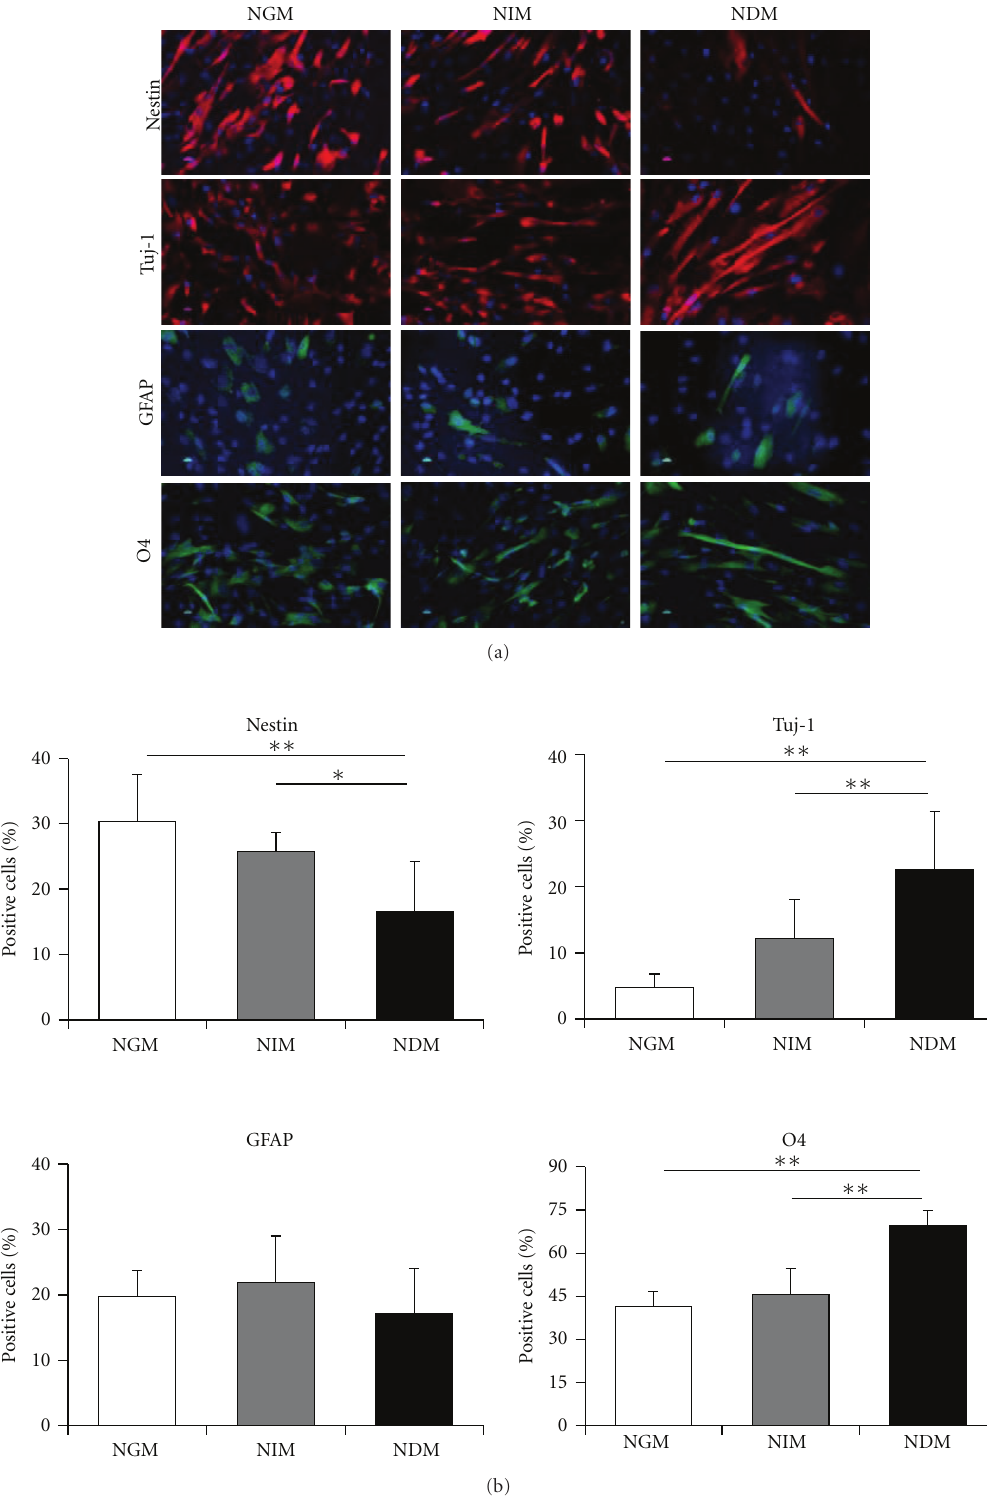
Figure 2: Neural marker expression of hMSCs during neural di ff erentiation. (a) Immunocytochemical analysis of di ff erentiated hMSC with neuronal lineage-specific antibodies ( × 300 objective). Cells that had been harvested 72hr after changing to a NDM were stained with the primary antibodies listed in Materials and methods. Hoechst 33328 was used for nuclear counterstaining. (b) Quantification of the percentage of stained cells from two di ff erent slides (10 fields of view, except in the case of O4 with 5 fields and Tuj-1 with 8 fields). Data represent mean ± SD. ∗ P < . 05 ∗∗ P < . 01. NGM: normal growth media; NIM: neural induction media; NDM: neural di ff erentiation